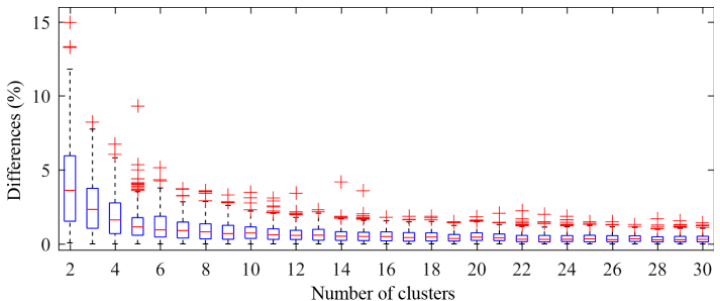
Figure 4. Statistical analysis on the differences of calculated annual operation costs.